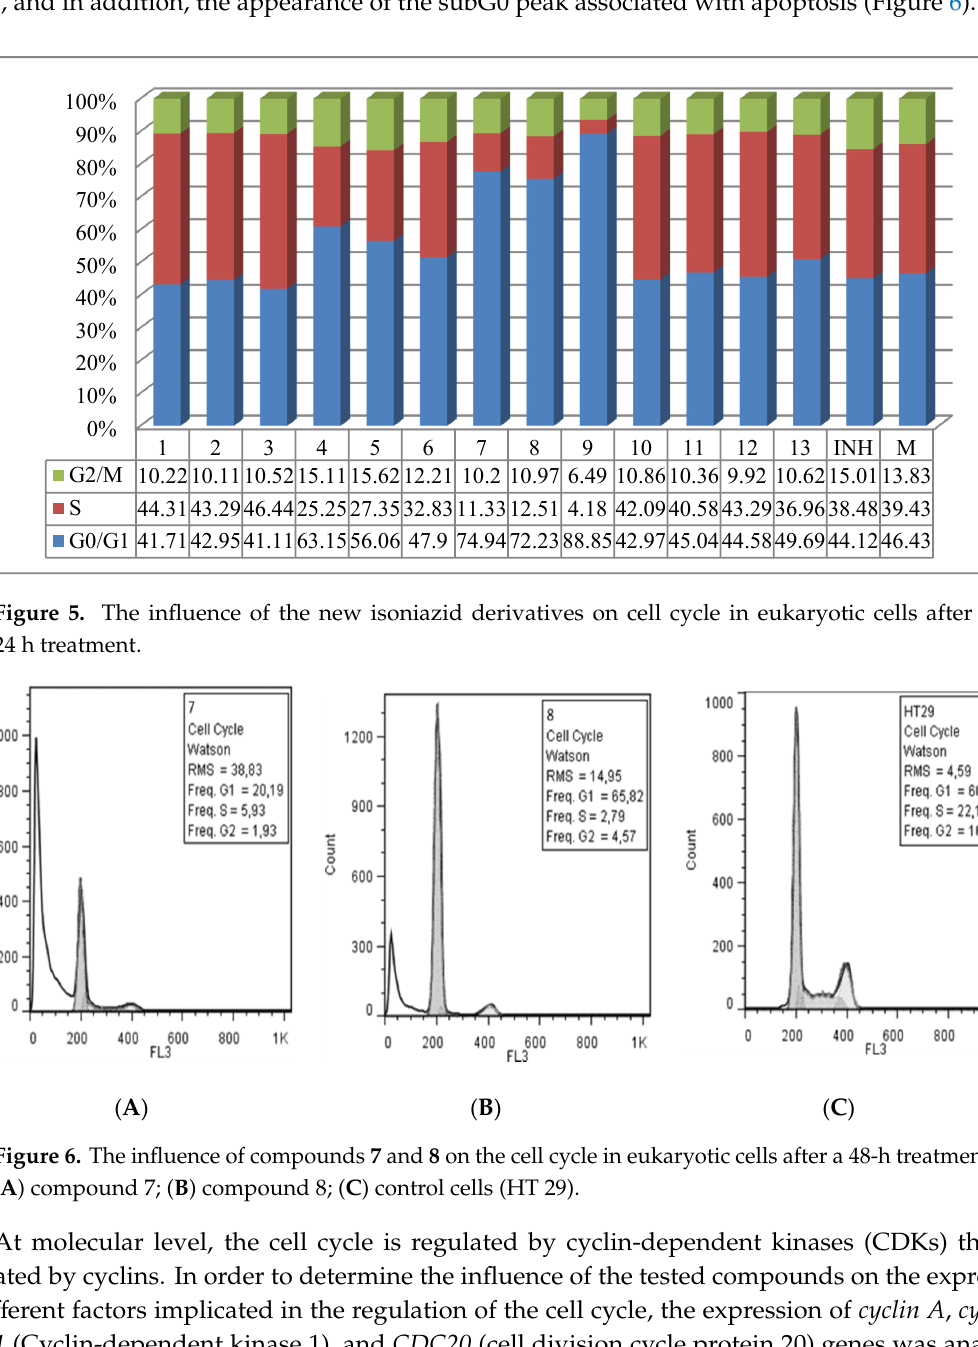
Figure 5. The influence of the new isoniazid derivatives on cell cycle in eukaryotic cells after a 24 h treatment.